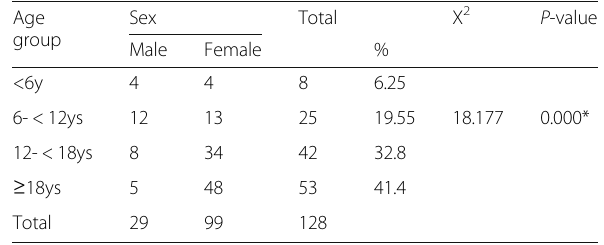
Table 2 Relation between age groups and gender in cases of domestic violence in south region, Jordan (n = 128)